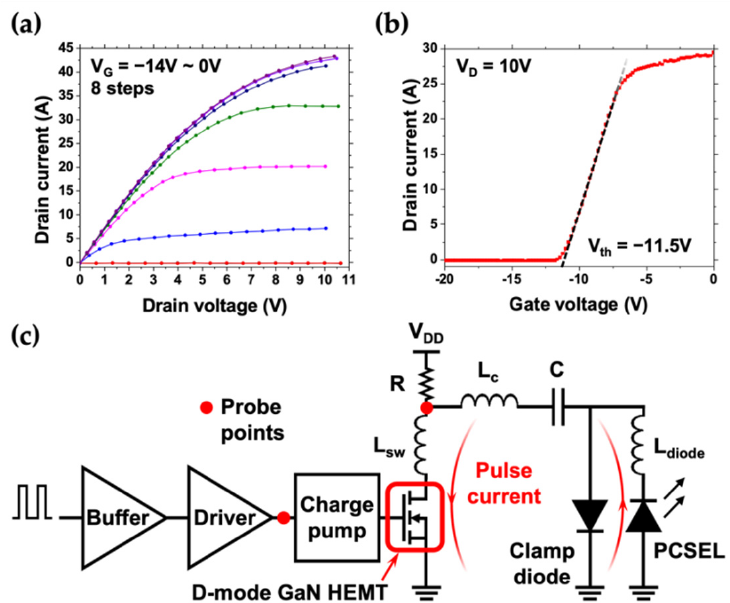
Figure 1. Electrical characteristics of the employed GaN HEMT and the topology of a laser driving circuit. ( a ) Output characteristics of the GaN HEMT operated under various gate voltages. The gate voltages are sequentially applied from − 14 V to 0 V in eight steps (starting from the very bottom with black and red overlapping curves). ( b ) Transfer curve of the GaN HEMT with a drain voltage of 10 V. The threshold voltage can be appraised around − 11.5 V. ( c ) Topology of a laser driving circuit with the PCSEL and GaN HEMT switch.